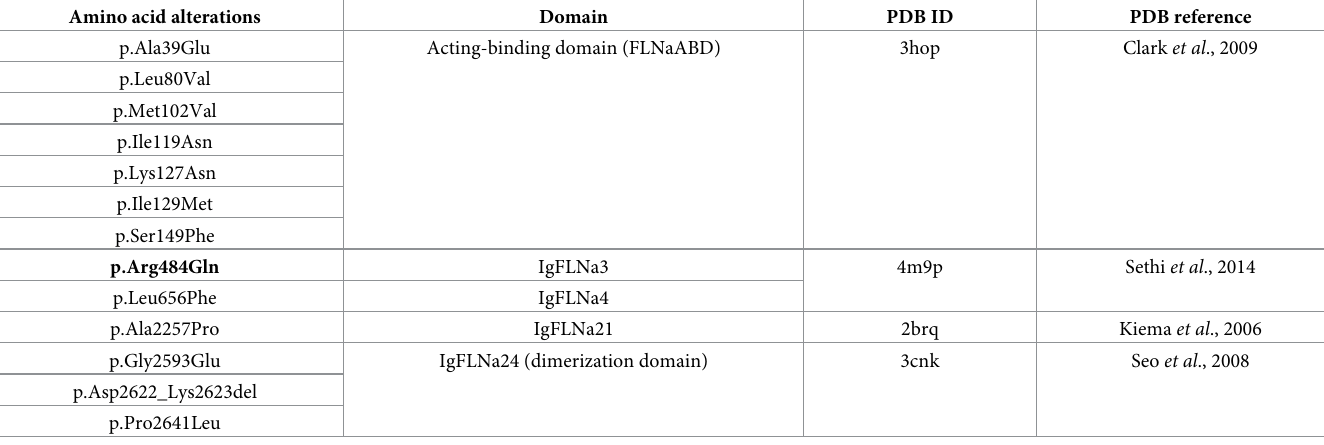
Table 1. The filamin-A (FLNa) variants reported in the liveborn male patients with periventricular nodular heterotopia. The full list given in S1 Table was filtered into this list to be able to study the impact of the variants via molecular dynamics simulations. Amino acid